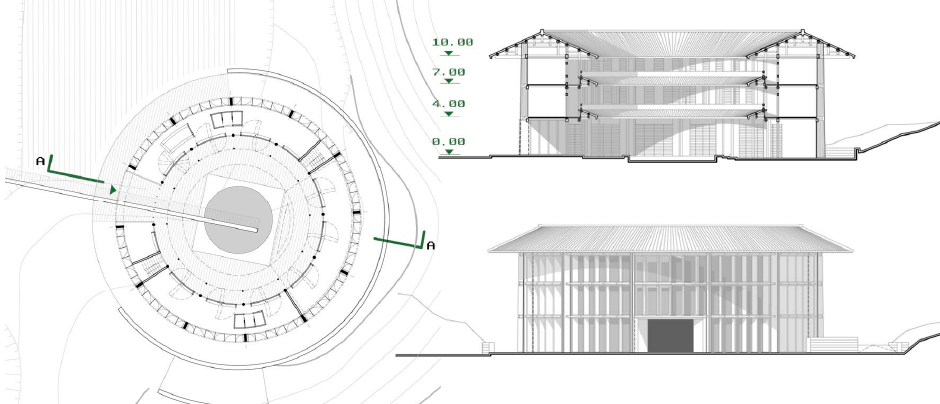
Figure 4. Plan and section of the rural makers’ co-working space, the art workshop village and the bamboo building.